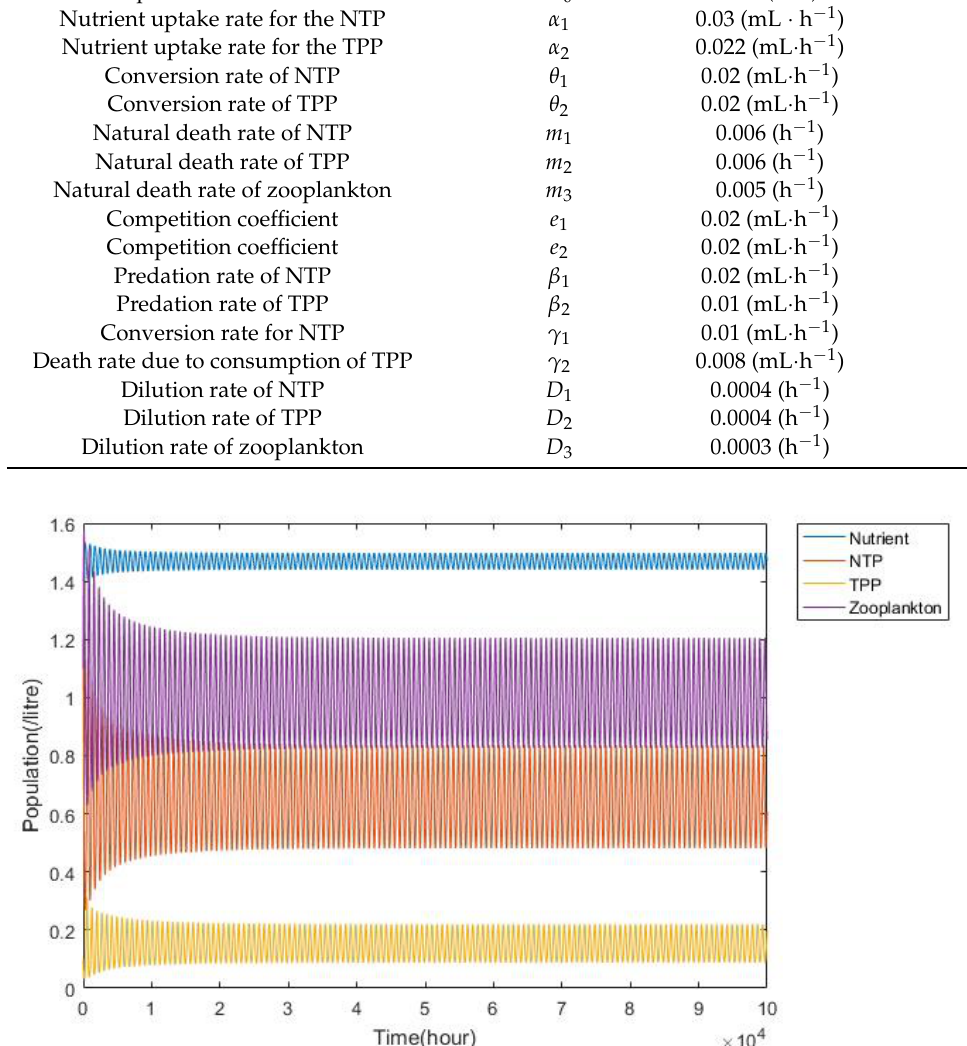
Figure 1. Simulation results of System (2) with τ = 0 < τ 0